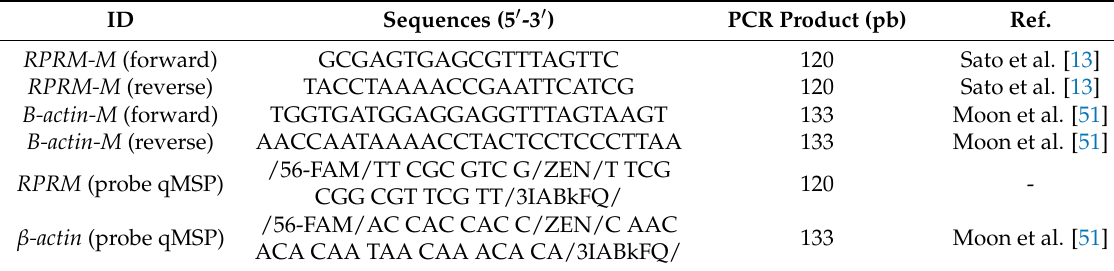
Table 2. Primer and probe sequences used in this